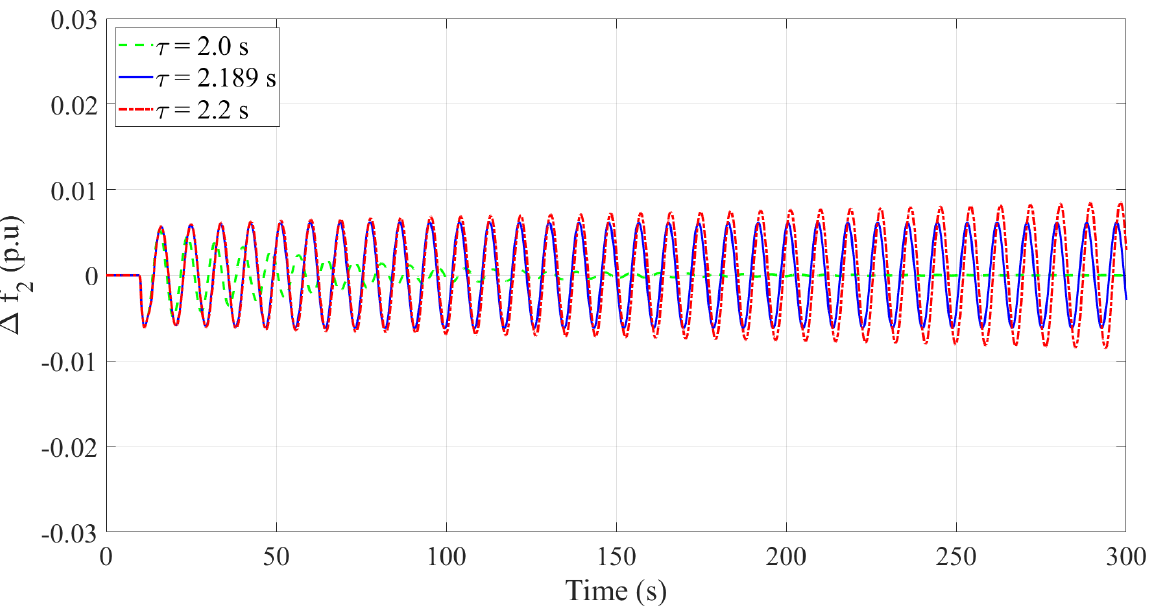
Figure 14. Frequency deviation for LFC − 2: ∆ f 2 was measured while using K P = 0.4 and K I = 0.6. Figures 13 and 14 depict the frequency response with time delay, τ , of 2.0 s, 2.189 s, and 2.2 s, for area 1 and area 2, respectively. It is obvious that the system is stable with τ = 2.0 s and unstable with τ = 2.2 s. Meanwhile, the system is marginally stable with τ = 2.189 s. The percentage inaccuracy while employing the simulation-based DM is 0.000%. Figure 15 depicts the spectral radius against the frequency for K P = 0.4 and K I = 0.6. It was found that the crossing frequency, ω c , was equal to 0.71530 rad/s with θ = 1.5658 rad. By solving Equation (31), we obtain the DM equal to 2.189